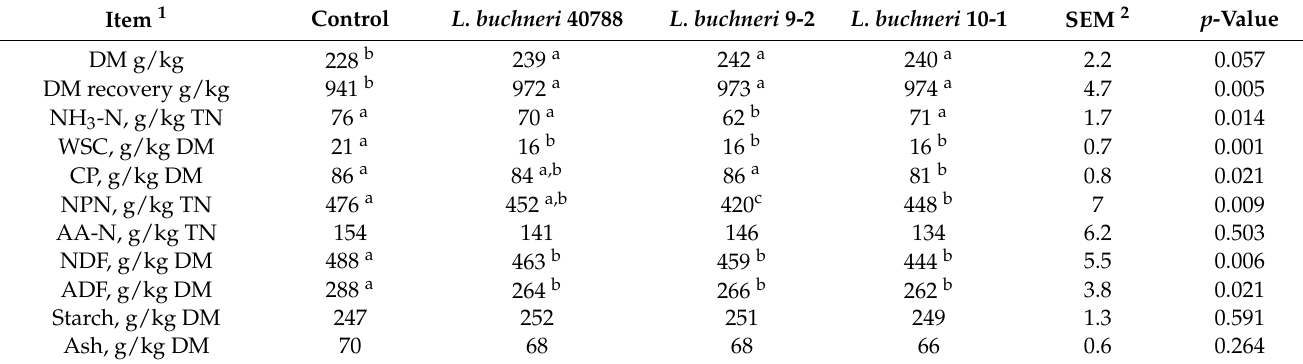
Table 4. Chemical composition of whole-plant corn silage after 90 d of ensiling